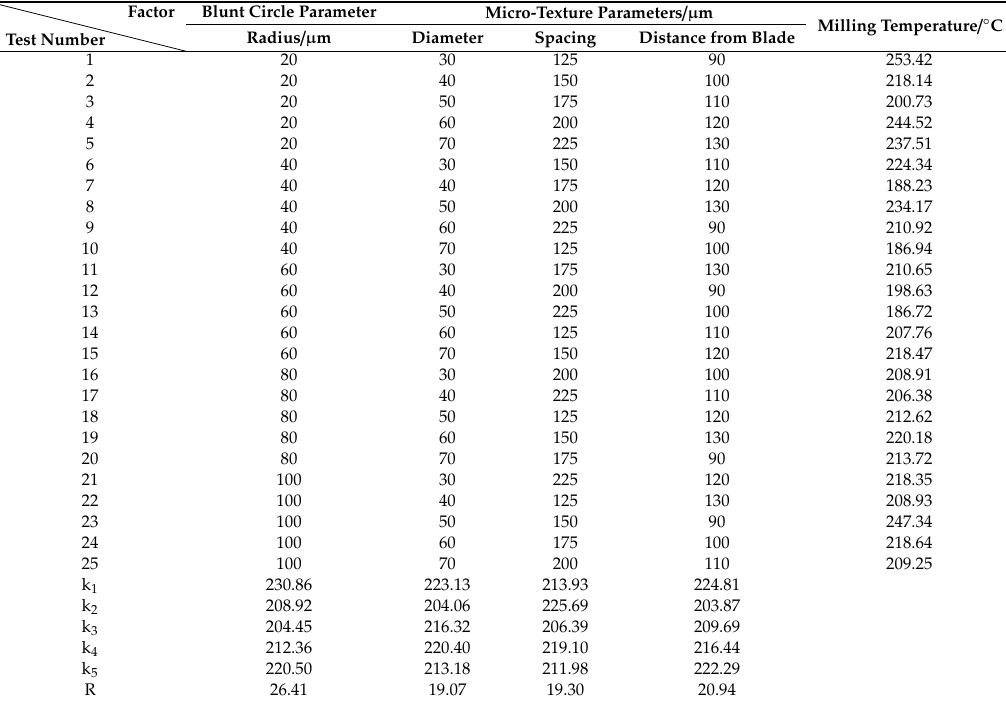
Table 3. Range analysis table of the milling temperature simulation